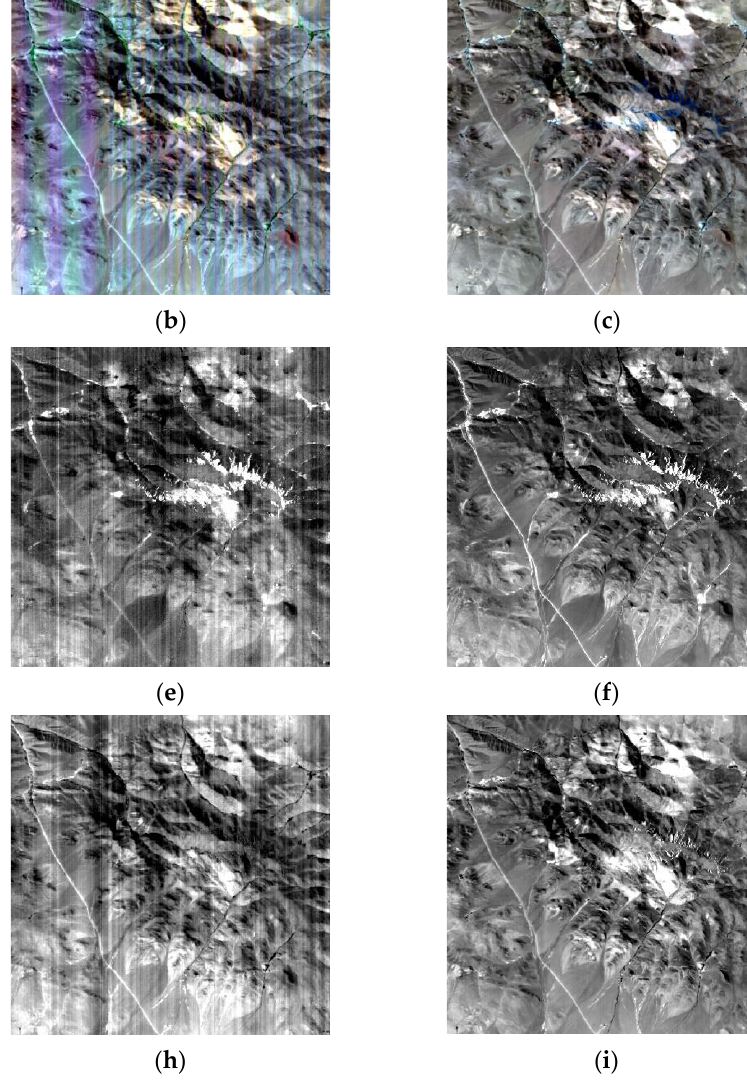
Figure 5. Denoised results by different methods in the GF-5 dataset: ( a ) Original false colour image